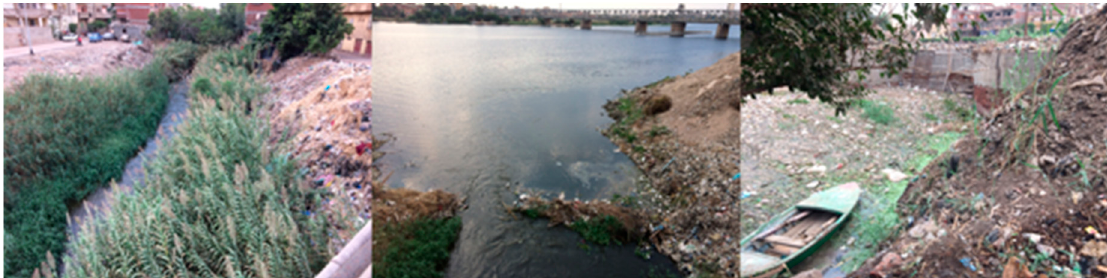
Figure 6. The Tilla drainage. Source: Author. Legend: The drainage is seriously polluted by different kinds of solid waste, as well as wastewater ( left ); the drainage discharges to the Nile river ( middle ); the drainage contains high level of eutrophication ( right ). Location: 30°49 ʹ 00.8 ʺ N 30°48 ʹ 48.6 ʺ E ( left and middle ) and 30°48 ʹ 46.6 ʺ N 30°50 ʹ 31.0 ʺ E ( right ).